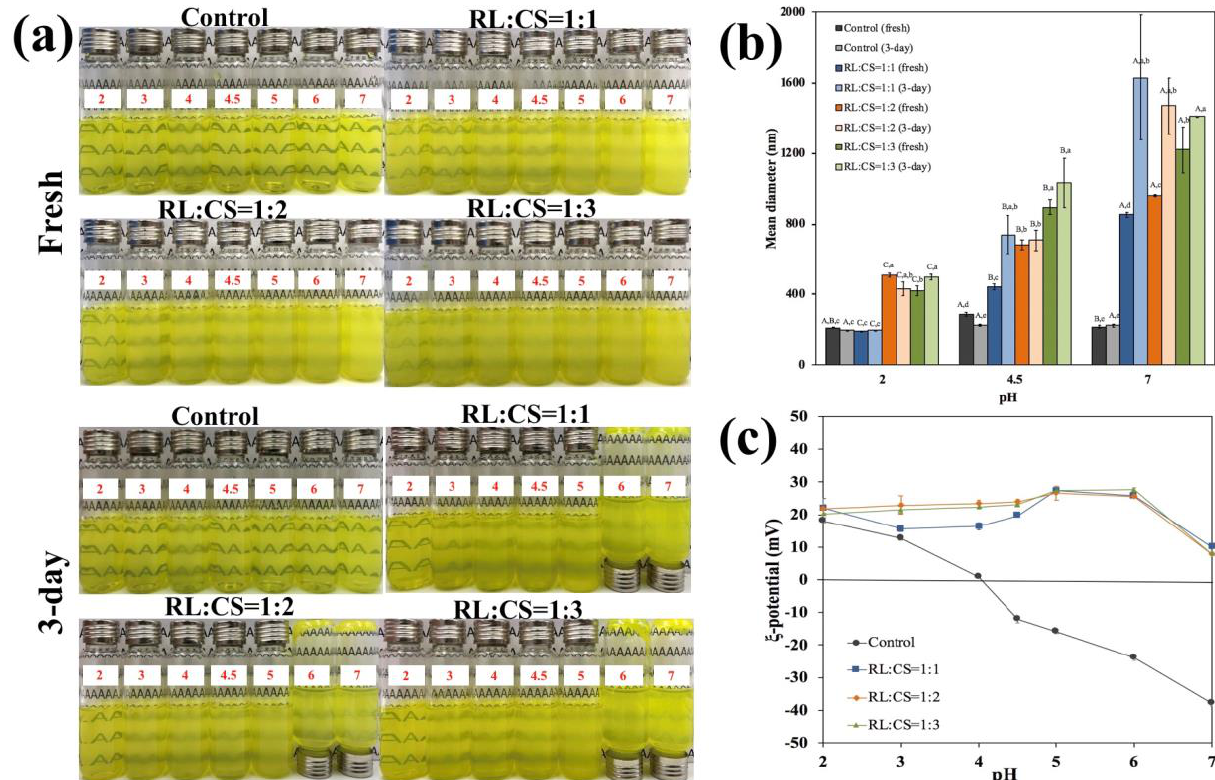
Figure 3. Influence of pH on the visual appearance ( a ), mean diameter ( b ) and ζ -potential ( c ) of liposomes with different ratios of RL/CS. Samples denoted by different capital case letters (A – C) were significantly different ( p < 0.05) when compared between different pH (same RL/CS ratios and storage time). Samples denoted by lowercase letters (a – c) were significantly different ( p < 0.05) when compared between different RL/CS ratios and storage times (same pH).